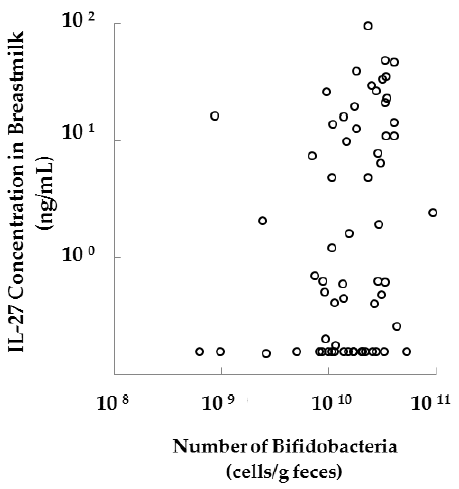
Figure A1. A significant correlation between the fecal bifidobacterial count in mothers and IL-27 concentration in their breast milk. The number of Bifidobacterium spp. was quantified by q-RT-PCR ( n = 29 and 34 for the placebo and FOS group, respectively). IL-27 in colostrum whey was detected using The Human IL-27 DuoSet ELISA kit (R&D Systems). Data were analyzed using the Spearman’s rank correlation coefficient ( p < 0.05).